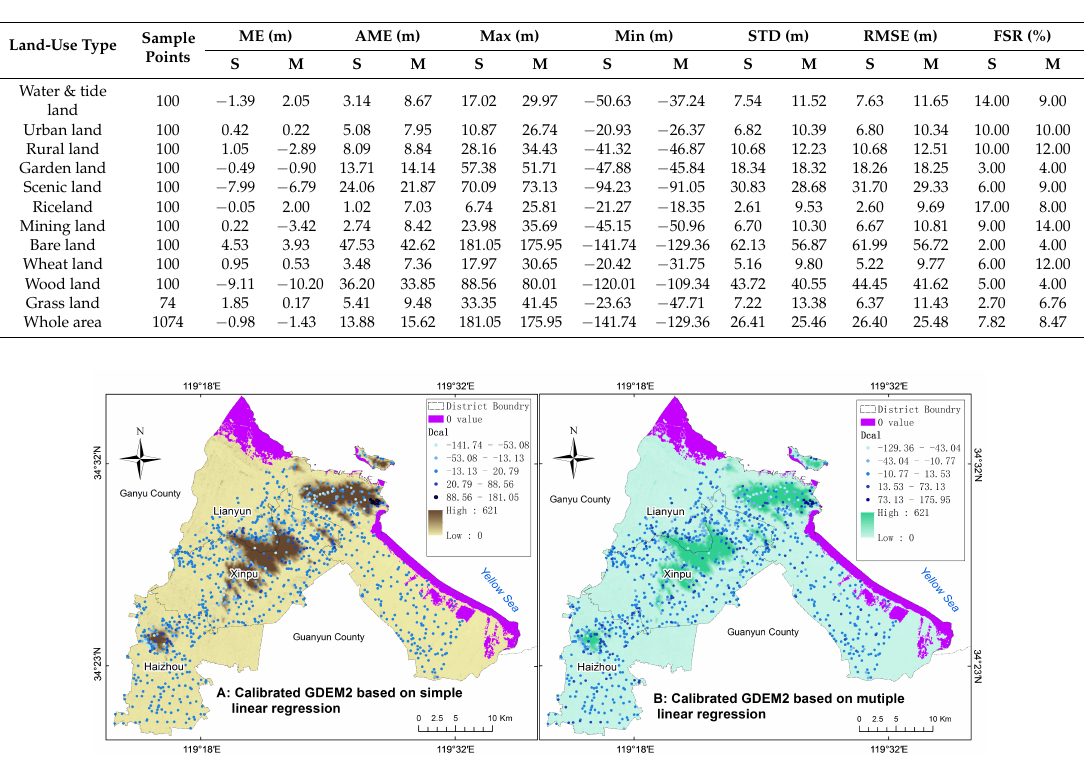
Table 5. Statistical measures of the elevation differences between the calibrated GDEM2 and the validation data. S indicates simple linear regression and M multiple linear regression.